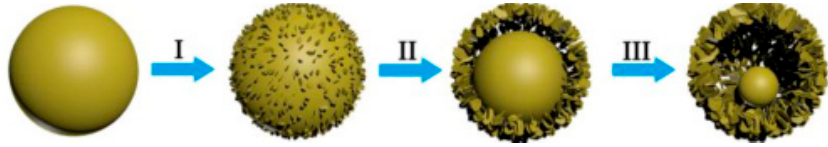
Figure 10. Ostwald ripening process of core-shell ZnFe 2 O 4 [47].